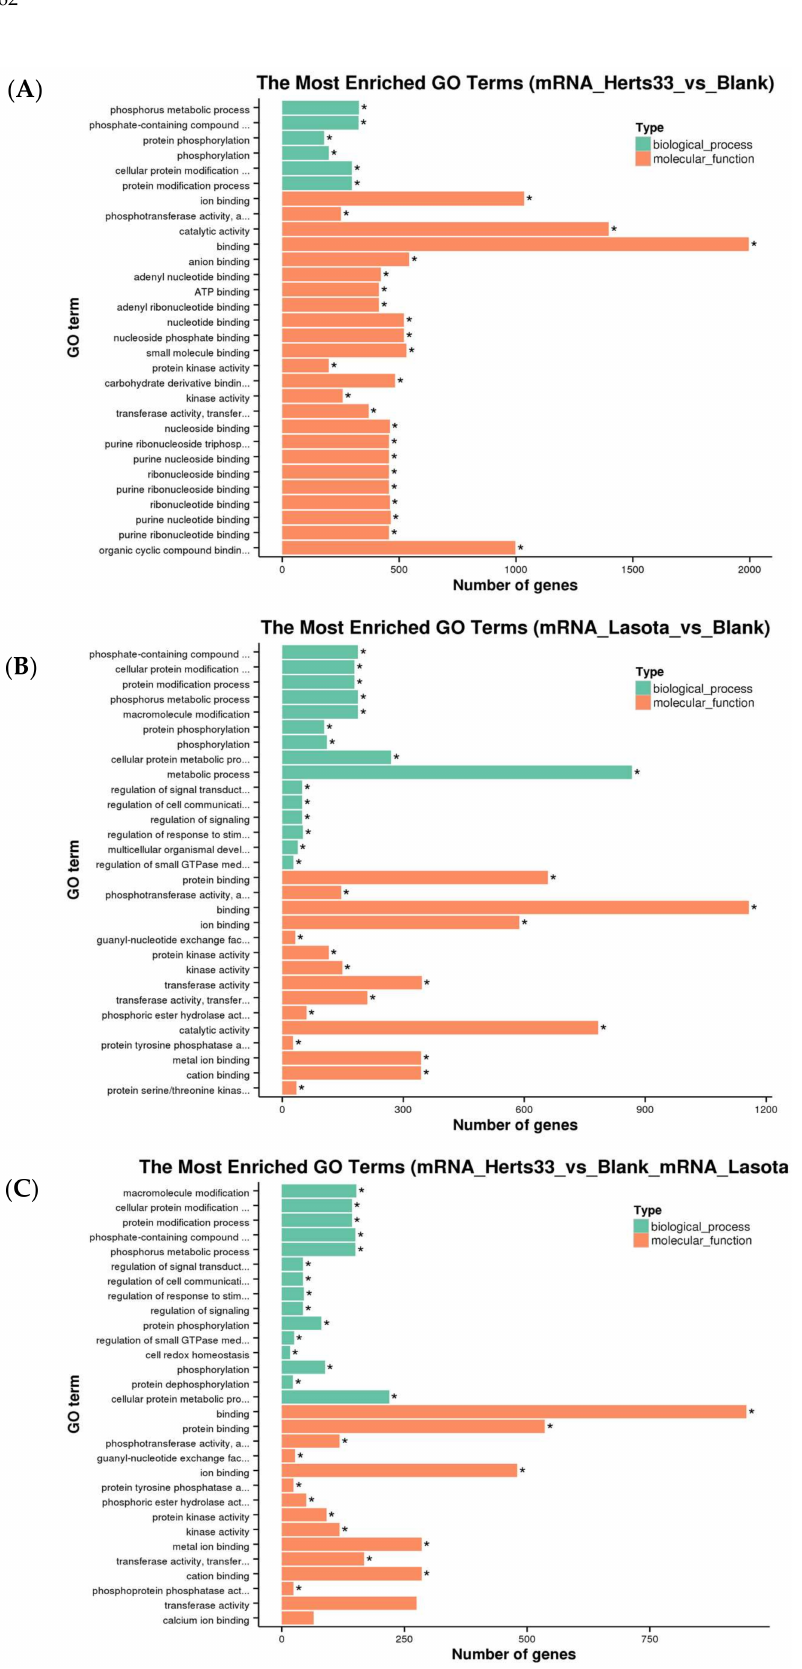
Figure 5. Gene ontology (GO) functional enrichment of differential ISGs . ( A ) GO analyses of differentially expressed ISGs in Herts/33 relative to the control ( B ) GO analyses of differentially expressed ISGs LaSota relative to the control; and, ( C ) GO analyses of differentially expressed ISGs common to both